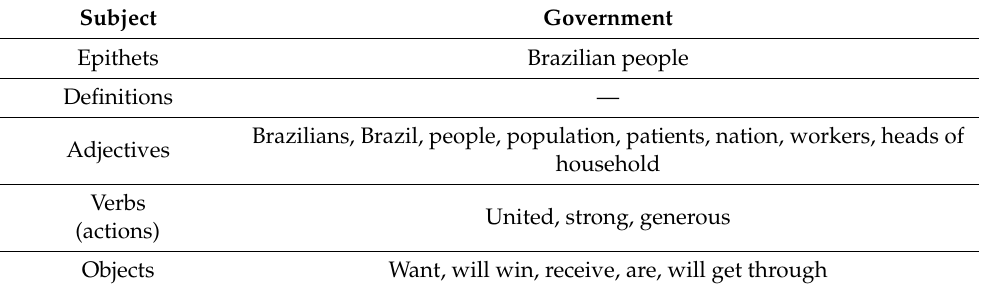
Table 15. Brazilian People